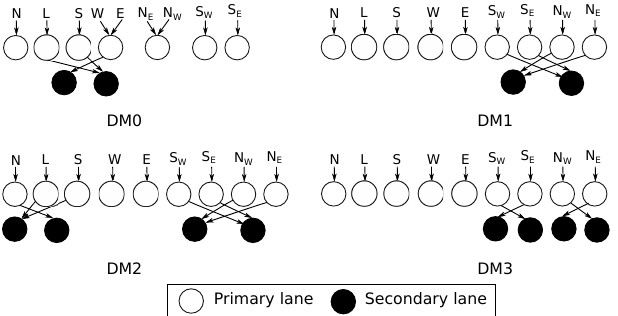
Figure 20. Considered R-NoC-D configurations. Table 4. Router configurations. Config.